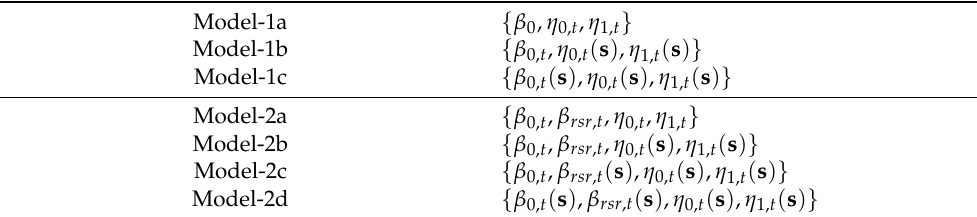
Table A1. The ST-LAR models for fitting the September Arctic SIE data. The mean of the latent y t ( s ) is either modeled by an intercept term or by using the RSR as a